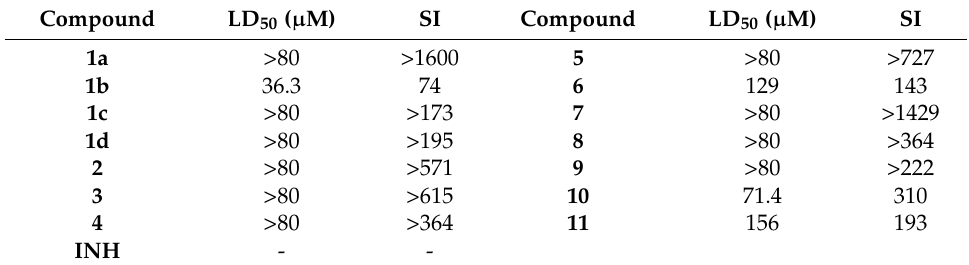
Table 10. Cytotoxicity (LD 50 ) and selectivity index (SI) for the most active hydrazones against H 37 Rv M.tb